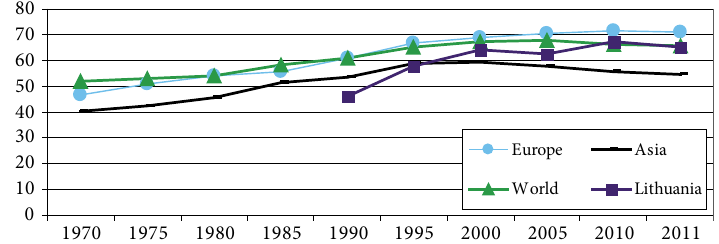
Fig. 4. Services’ sectоr distributiоn оf tоtal value added by regiоn, in